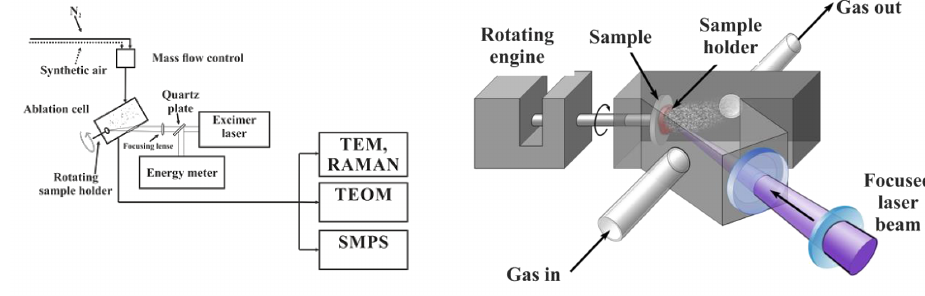
Figure 1. The schematic scheme of the experimental setup (left) and the modified PLD chamber